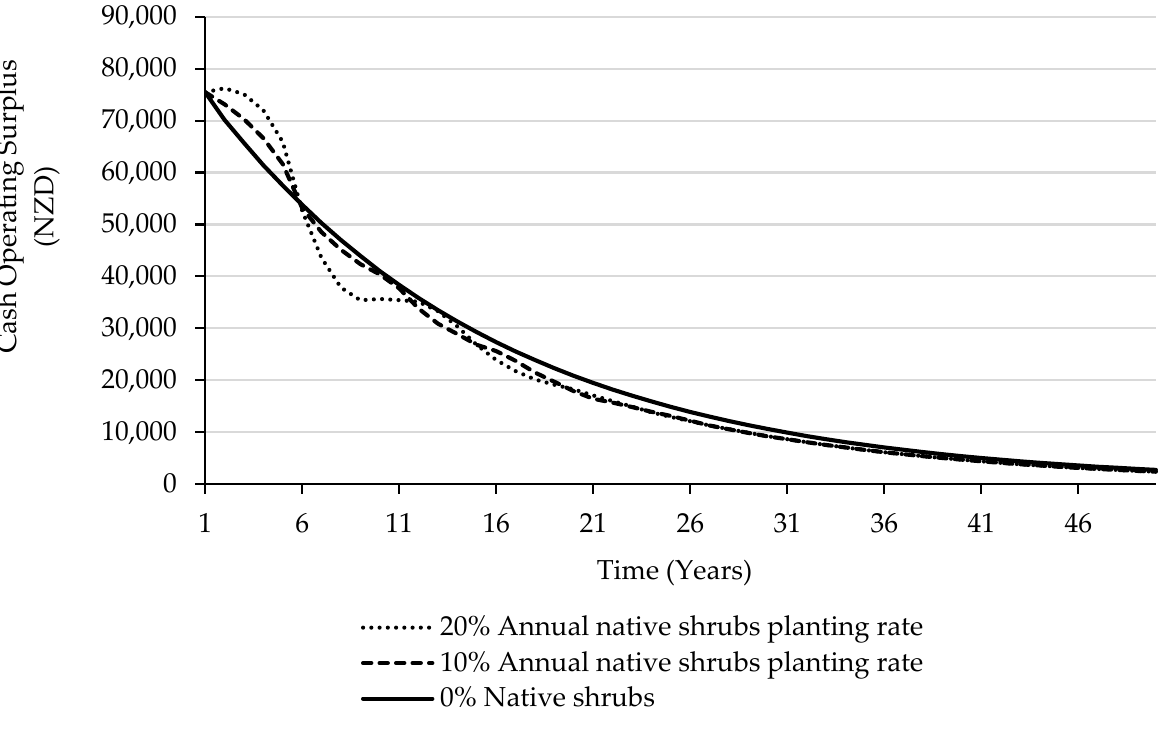
Figure 5. Annual sheep flock cash operating surplus (COS) discounted at 7% per year over 50 years for native shrubs planted on 10% of the modelled farm at 0%, 10%, and 20% planting rates per year.